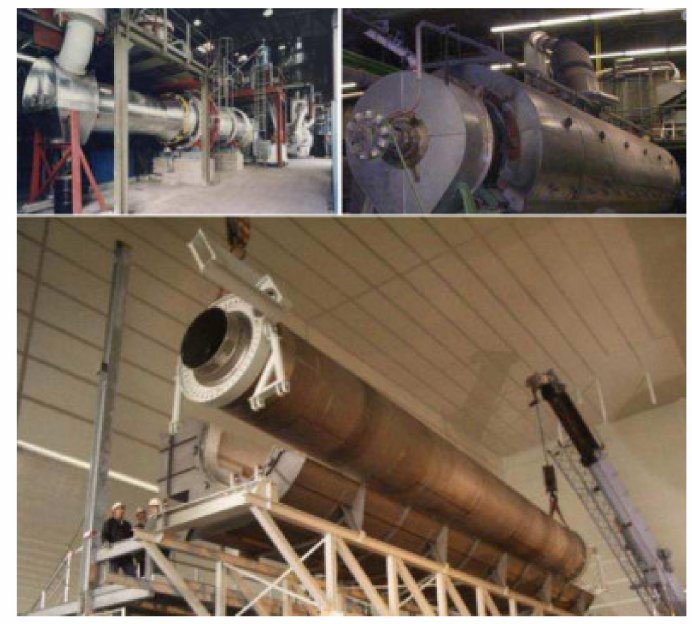
Figure 2. Reactor for Euphore-type